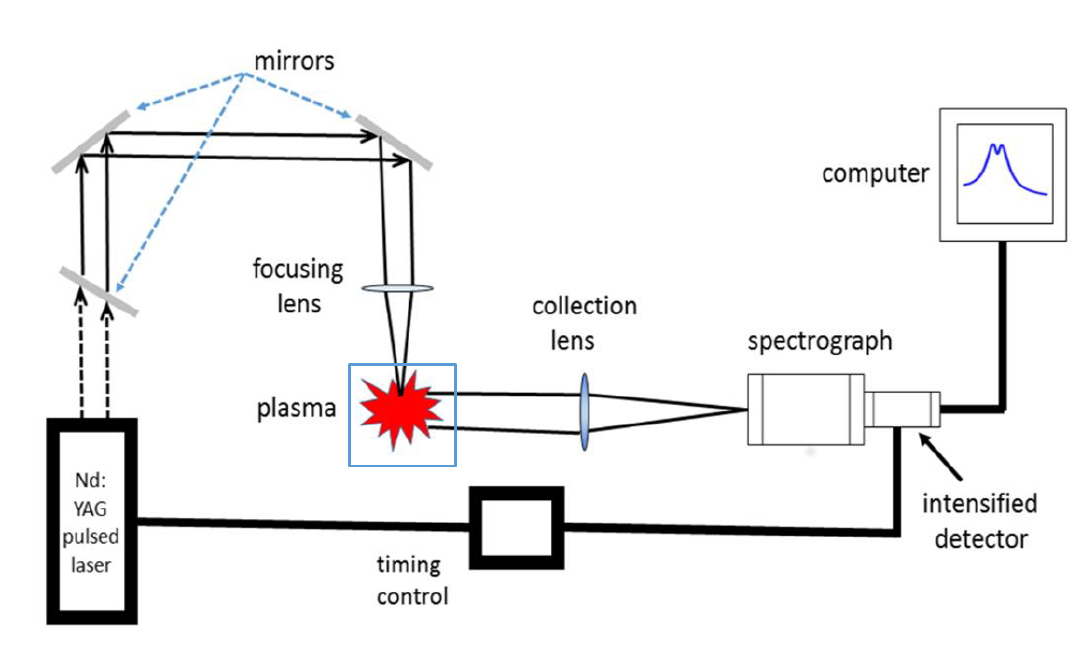
Figure 7. Typical experimental arrangement for generation and measurement of laser-induced